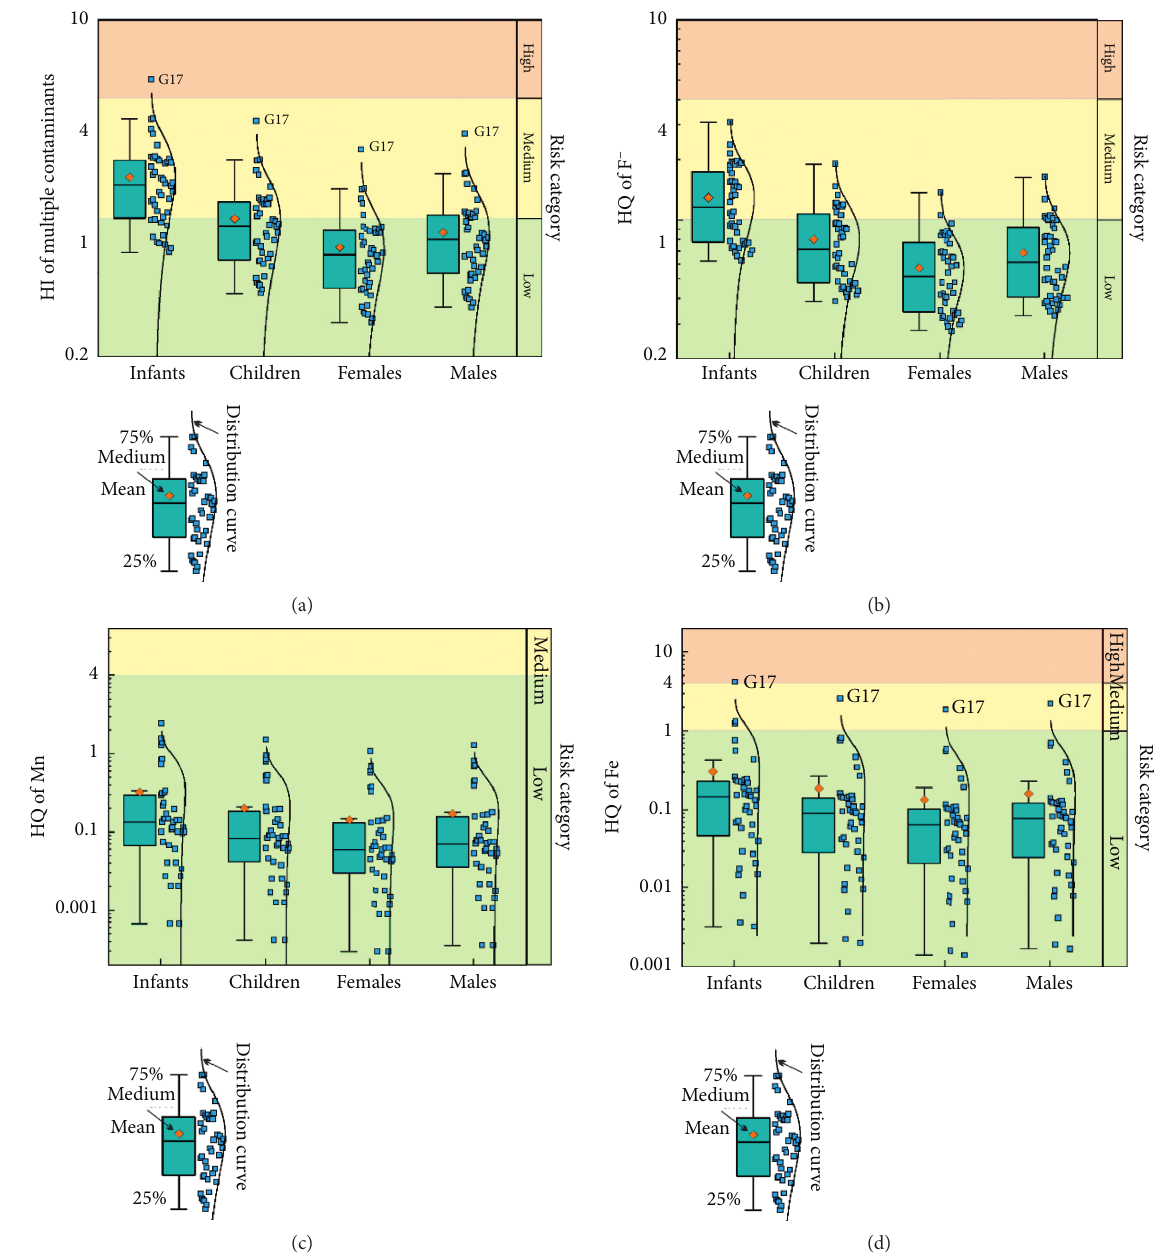
Figure 10: Box plots of (a) the overall noncarcinogenic health risk due to multiple contaminants and the hazard quotient of the non- carcinogenic health risk posed by a single contaminant of (b) F − , (c) Mn, and (d)